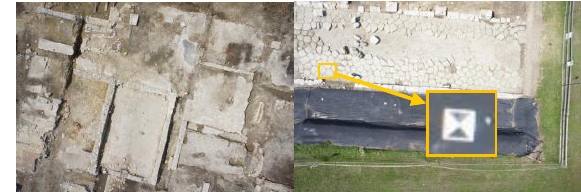
Figure 8 Two acquired images in the area of Via Gemina: high flight (left) and low flight with a zoom on a target (right). According to the BBA results, the orthophotos were realized at a scale of 1:100 for the low flight (14 m) and 1:200 for the high